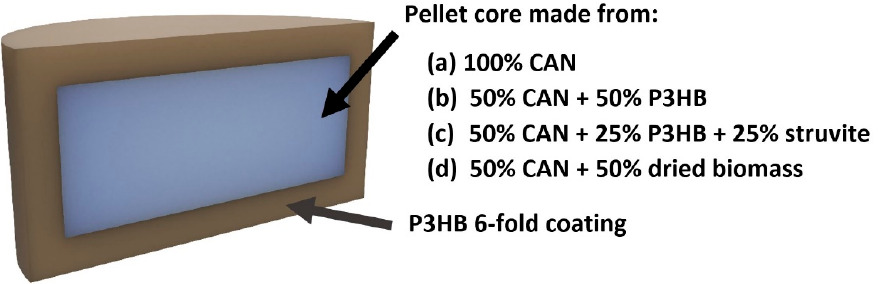
Figure 2. Schematic representation of coated pellets. Table 5. Calculated average weight (%, n = 10) and standard deviation of manually applied 6-fold coating for all pellet formulations prepared on a hydraulic